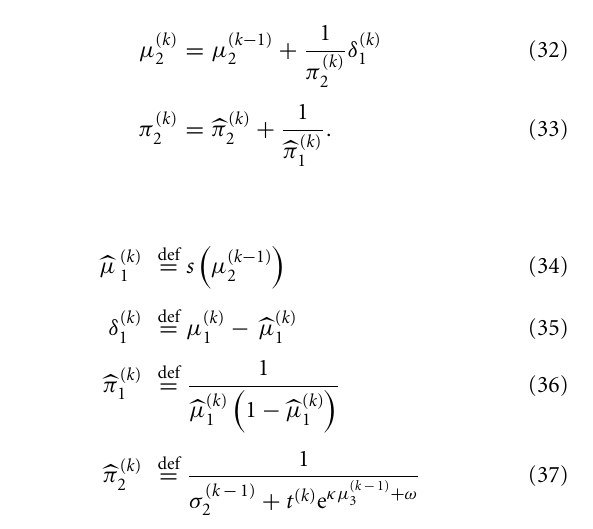
They generate u ( k ) , the input at time point k , and depend on their immediately preceding values x ( k − 1) 2 , x ( k − 1) 3 and on the on parameters κ , ω , ϑ . Right: model definition. This figure has been adapted from Figures 1, 2 in Mathys et al.